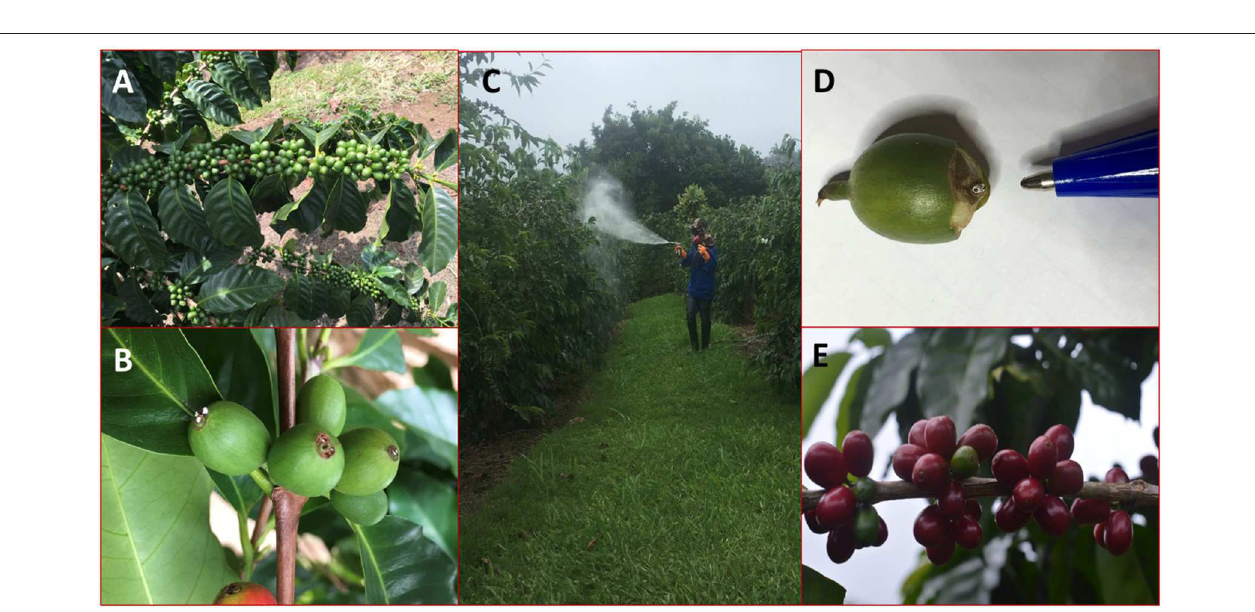
FIGURE 1 | Stages of coffee berry borer (CBB) penetration in green berries. (A) “AB position” where female CBB is vulnerable to insecticides (berries 60–140 days old). (B) “CD position” where CBBs are protected within the endosperm (berries > 140 days old). (C) CBB in “AB position” killed by Beauveria bassiana . (D) Infested berry with missing CBB.